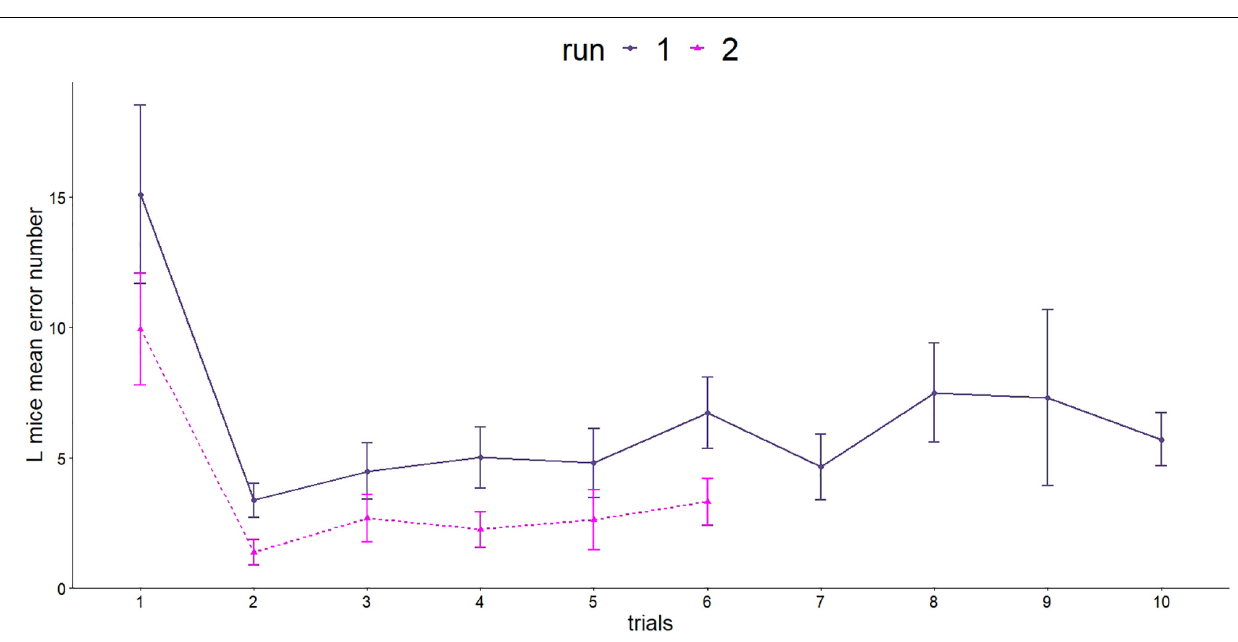
end of the measurement 34.12 g. When the mice were housed and NL mice (GLMM, post hoc comparison, t = − 2.71, p =